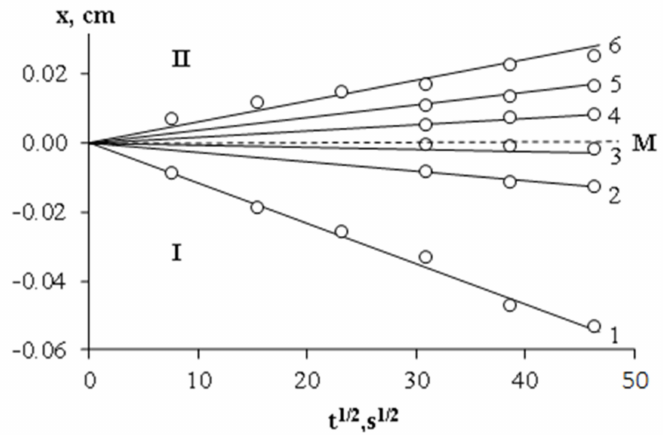
Figure 11. The kinetic dependences of the movements of isoconcentration planes in the PCL (M n = 45 × 10 3 ) – DGEBA system at 80 ◦ C. PCL concentrations are indicated near the straight lines. M is the Motano–Boltzmann plane, I corresponds to the diffusion zone of PCL in DGEBA, II corresponds to the diffusion zone of DGEBA in